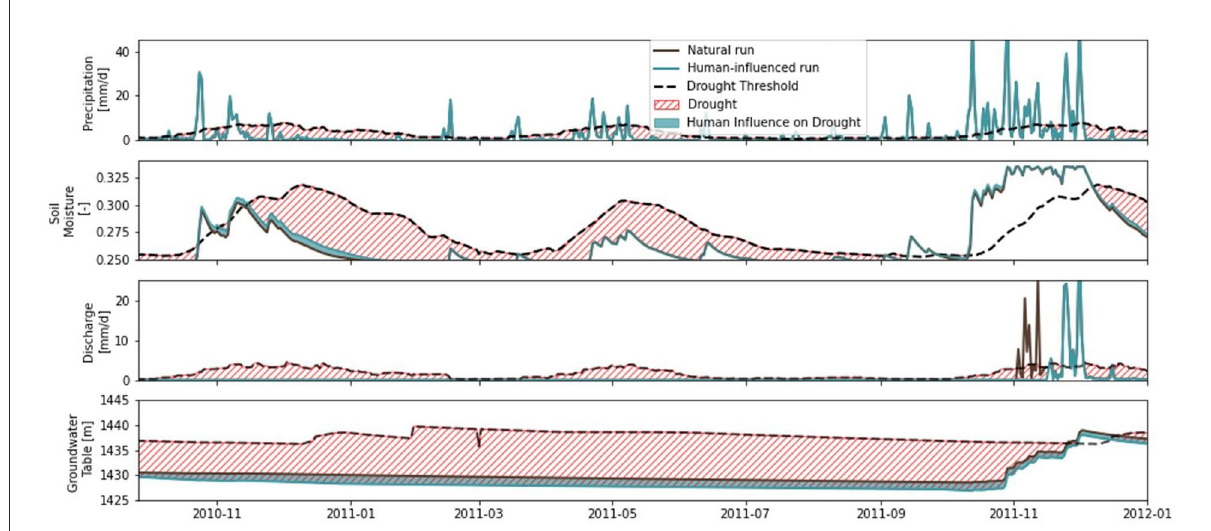
FIGURE6 Influence of agents on different types of drought from the 2010 OND to 2011 OND season. The fixed black line shows natural conditions over time without the influence of agents. The drought severity (red shaded area) is the deficit between natural and human-influenced conditions (fixed brown and turquoise lines) and the drought threshold (dotted black line). Precipitation, soil moisture and groundwater table are catchment averages, while discharge shows point values at the catchment